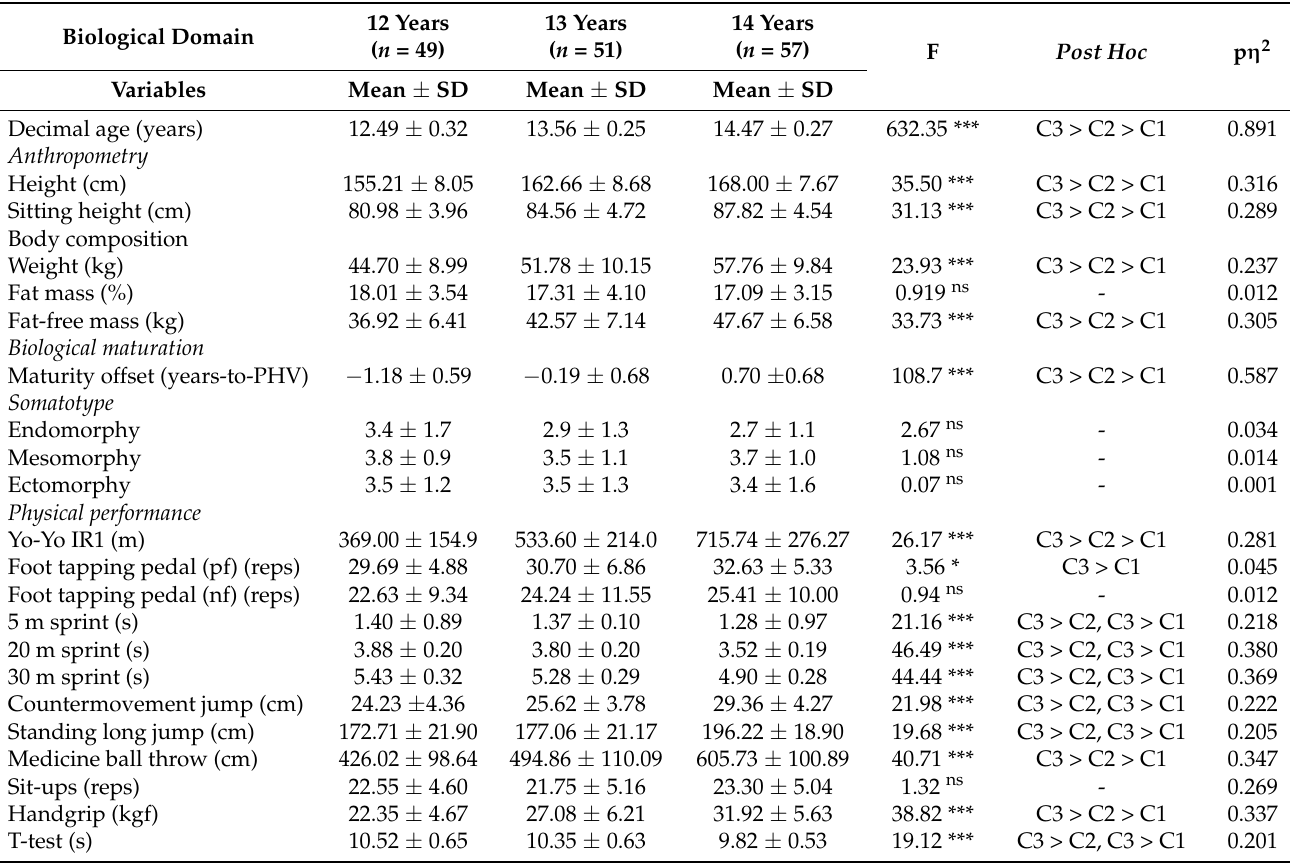
Table 3. Descriptive statistics [means and standard deviations (SD)], ANOVA results (F and post hoc tests), and partial eta square (p η 2 ) for the biological